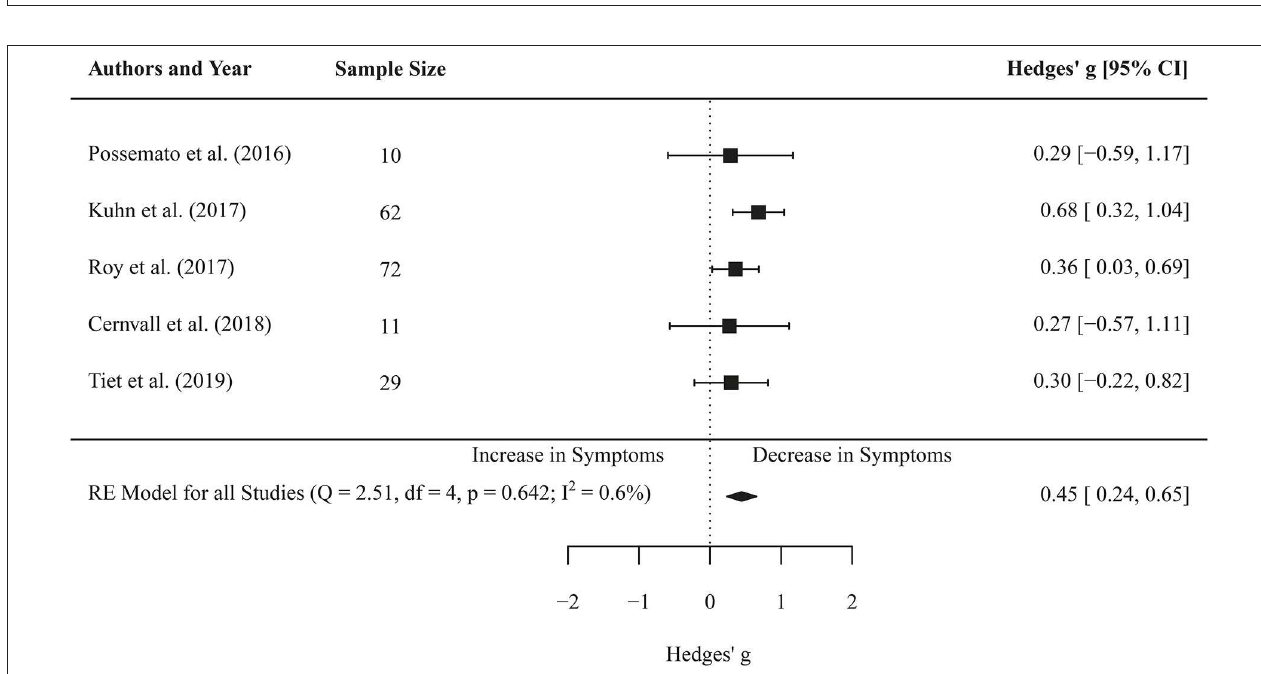
symptom reduction in waiting list controls compared to an effect post treatment of g = 0.79 in the treatment groups. Studies were rated with moderate-high